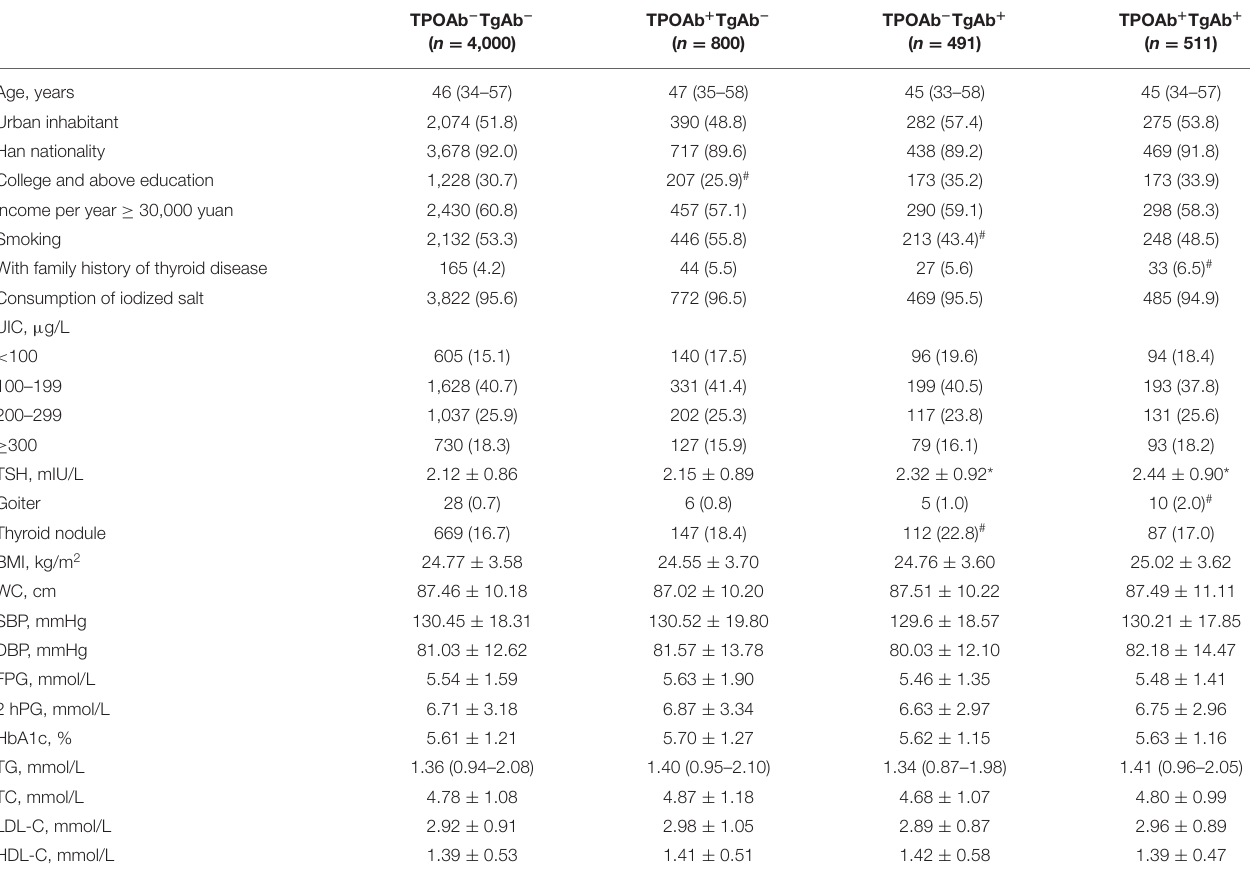
TABLE 1 | Characteristics of male subjects with differential expressions of serum TPOAb and